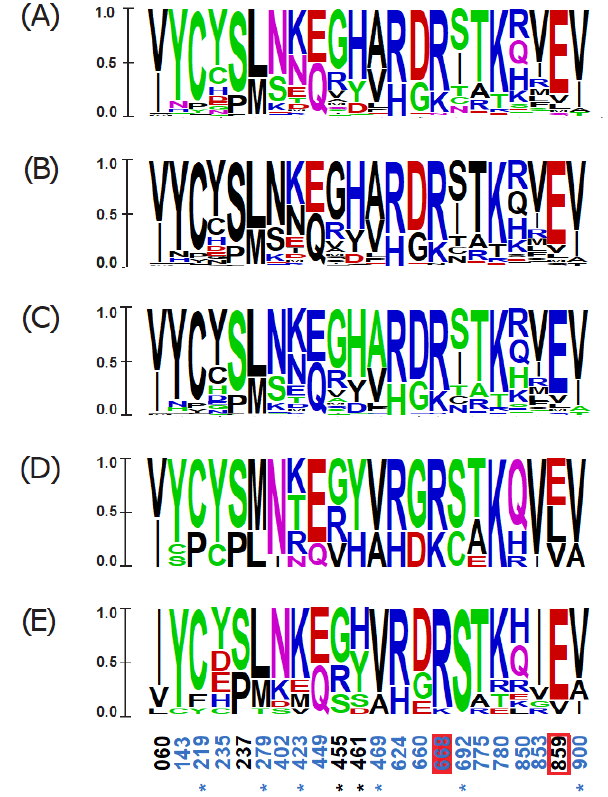
Figure 5. Physicochemical properties of the positively selected sites in avian RIG-I gene. Letter diagrams show the proportion of specific amino acids in RIG-I in all species ( A – C ), in nine species with the disrupted MDA5 ( D ), and in fifteen closely related species with functional MDA5 ( E ). Size of a letter indicates the frequency of a particular amino acid within the sequence alignment. Amino acid substitutions are coloured according to their physicochemical properties. For rows ( A , D , E ) acidic amino acids are in red, basic in blue, neutral in purple, polar in green and hydrophobic in black. For PSS in all species, charge (negative in red and positive in blue; ( B ) and hydrophobicity (hydrophilic in blue, hydrophobic in black, and neutral in green; ( C ) are also shown separately. Surface accessible amino acids assessed from the “open” model are in blue and PSSs identified also in other studies